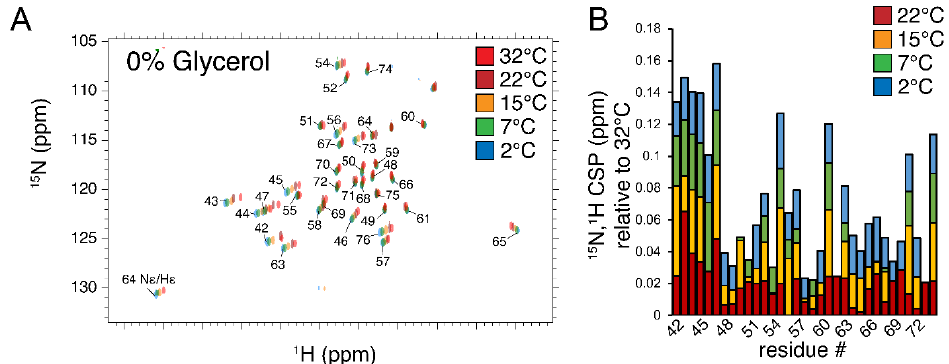
Figure 3. Overlay of backbone 15 N- 1 H correlation spectra for five temperatures ( A ) and corresponding bar graph of chemical shift perturbations versus residue number relative to the highest temperature of 32 ◦ C ( B ). The combined CSP is defined as: [31] 15 N, (cid:114) (cid:104) (cid:105) 1 H CSP = 0.14 2 ( δ N ( 32 ◦ C ) − δ N ( T )) 2 + ( δ H ( 32 ◦ C ) − δ H ( T )) 2 . The data were collected using homogeneously 15 N labeled and perdeuterated HP36 protein.